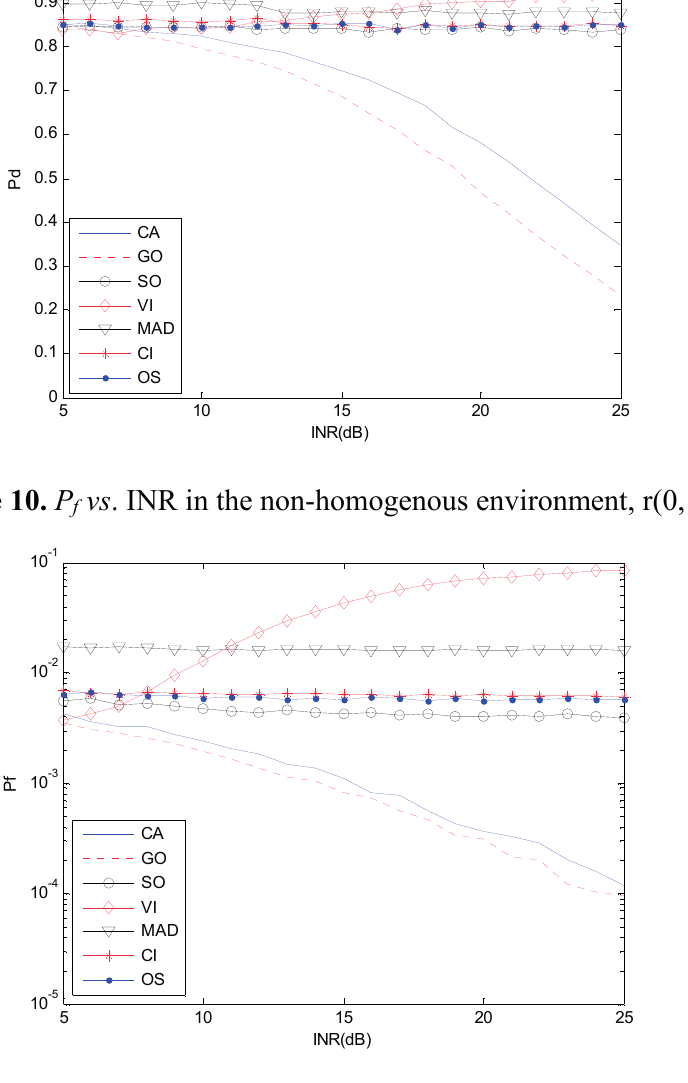
Figure 11. P vs . INR in the non-homogenous environment, d